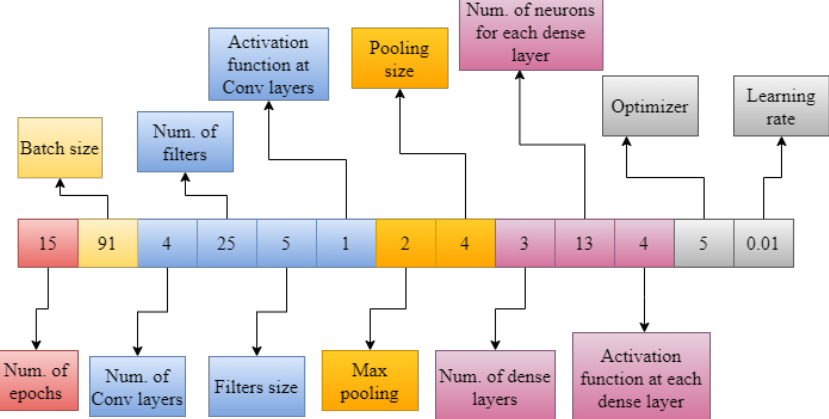
Figure 3. Randomly generated antigen, representing a CNN